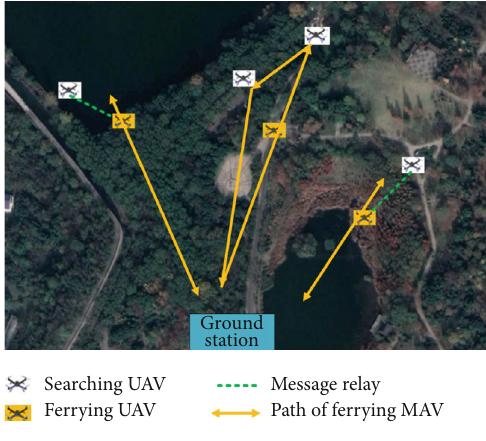
Figure 1: The scenario of